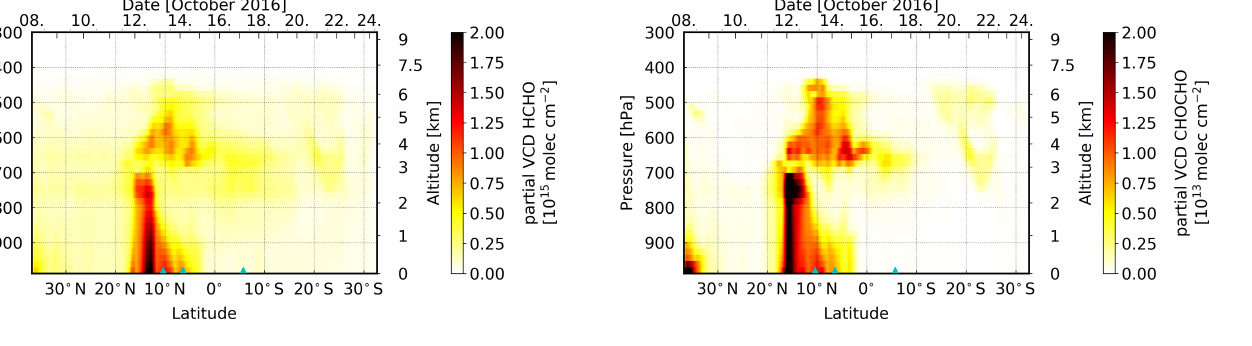
Figure 14. CHOCHO MOZART-4 profiles as used for VCD calcu- lations, interpolated on the cruise track (from north to south). The blue triangles on the bottom indicate the position of RV Maria